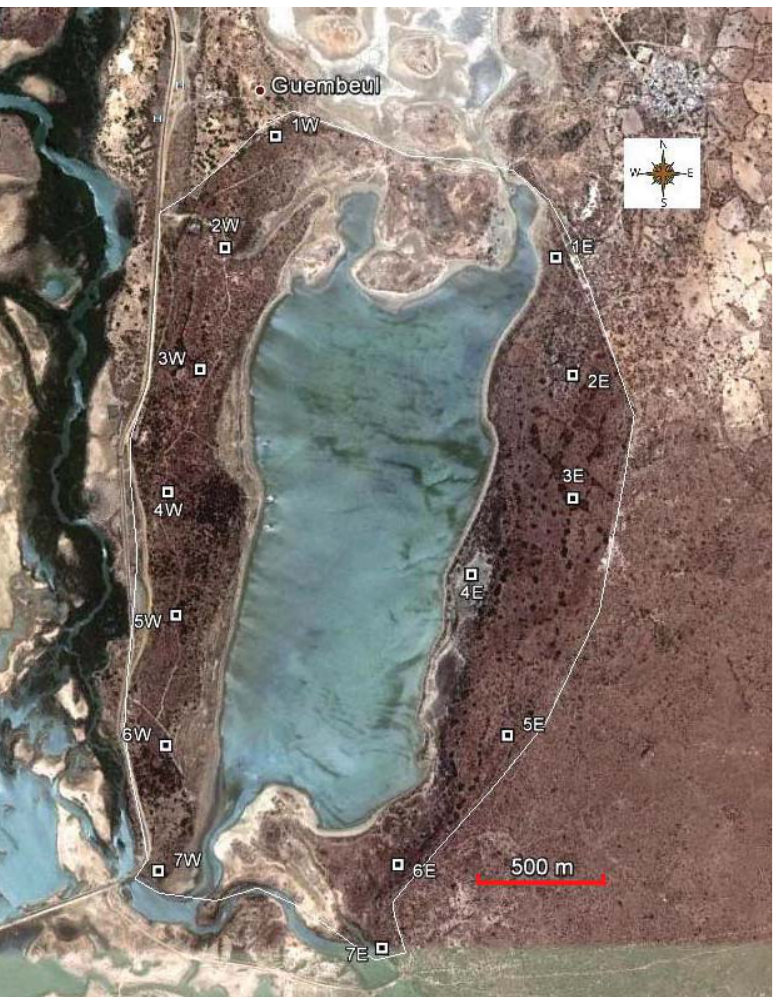
Figure 1. Map of the Reserve of Fauna of Guembeul showing plots where habitat structure has been sampled (15°55'N; 16°28'W). The central lagoon divides the Reserve into a western part and an eastern part, each of them containing seven sampling plots